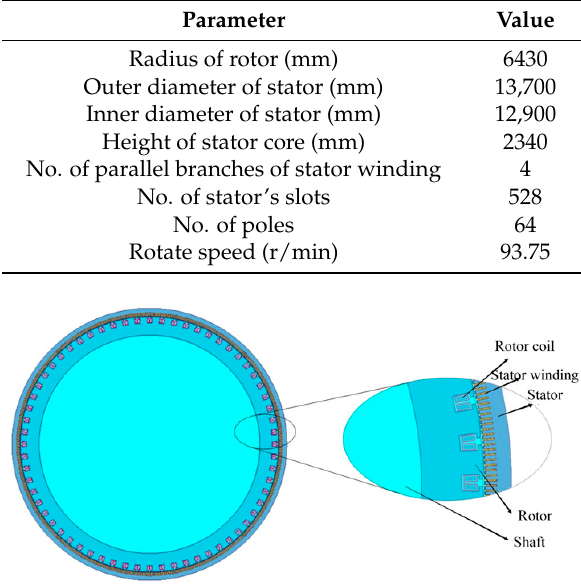
Figure 7. 2D model of electromagnetic analysis.